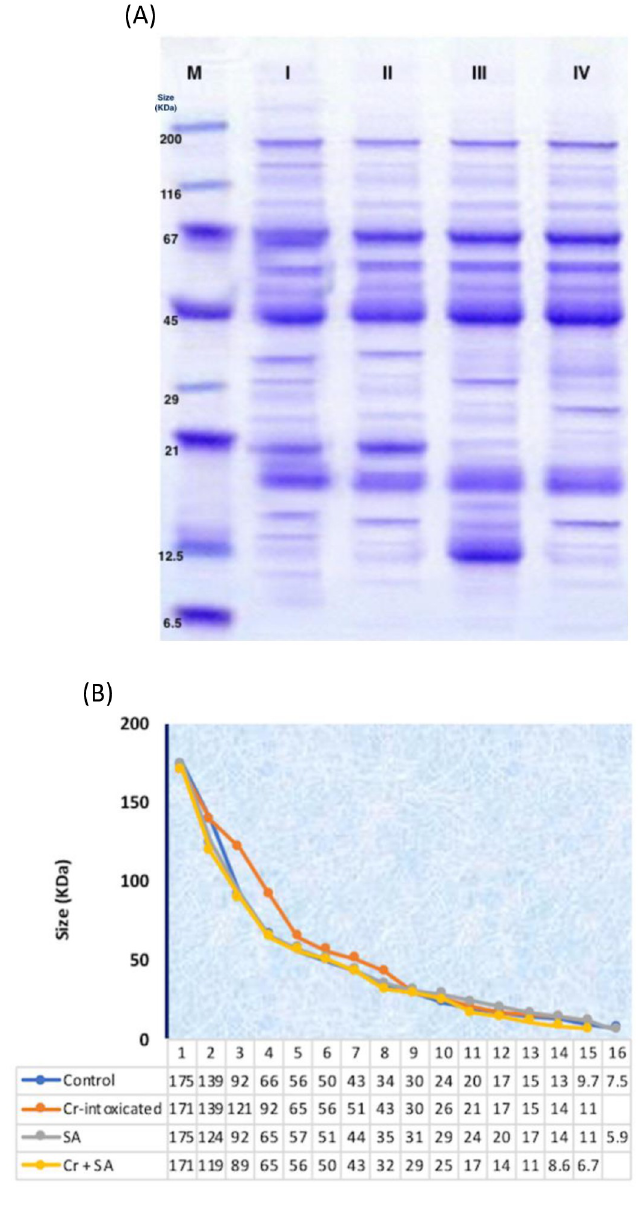
Fig 4. Protein pattern in brain tissues of different groups. (A): 12% SDS-PAGE for separation of loaded samples (B): A representative graph showing the different size of the separated proteins. M: Protein marker with size (KDa). I, II, III and IV refer to control, Cr-intoxicated, SA, and SA-treated groups,